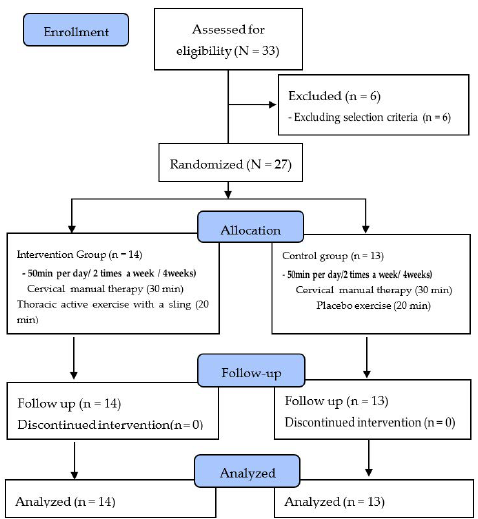
Figure 3. Presence of the different classes of volatile organic compounds (VOCs) in the fifteen fermented sausage samples considered. The values are expressed as the ratio between the peak area of the compound considered and the area of the internal standard.